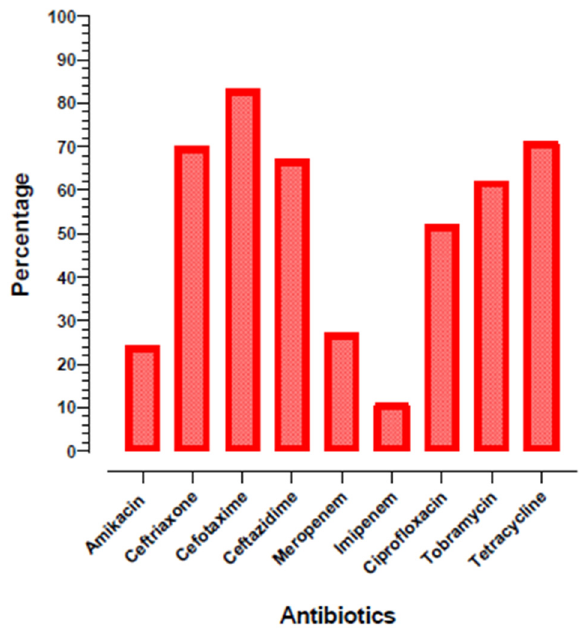
Figure 1. The percentage of antibiotic resistance profile of nine antibiotics against 125 K. pneumoniae isolates.